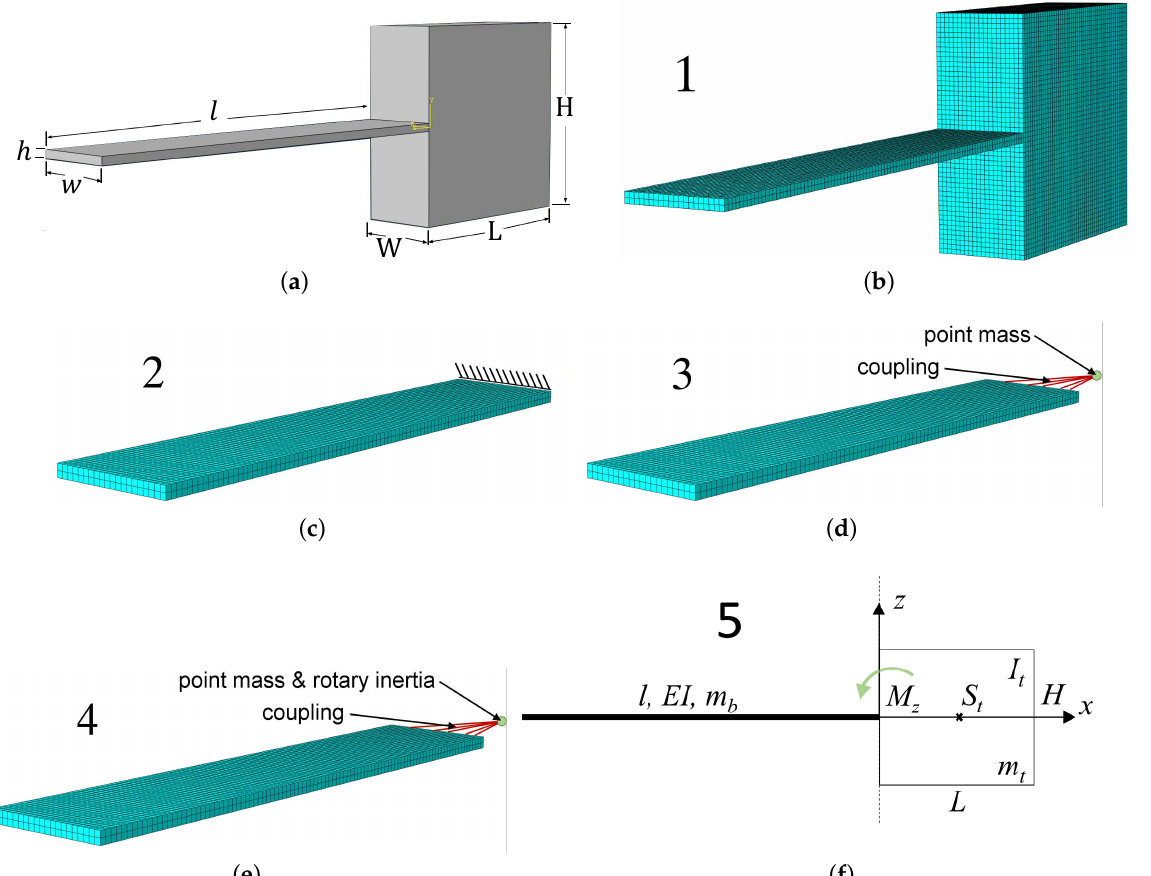
Figure 1. Investigated structure and finite element models. ( a ) Geometry of the specimens. Coordinate axes follow: length of beam ( l ) x–axis, beam thickness ( h ) z–axis, and beam width ( w ) y–axis. ( b ) Finite element model 1 of the real structure with ideal free–free boundary condition—reference model. ( c ) Simplified finite element model 2 with ideal rigid clamping. ( d ) Simplified finite element model 3 with ideal free-tip mass modelling. ( e ) Simplified finite element model 4 with ideal free-tip mass and rotary inertia modelling. ( f ) Euler–Bernoulli beam model 5 with ideal free-tip mass and rotary inertia